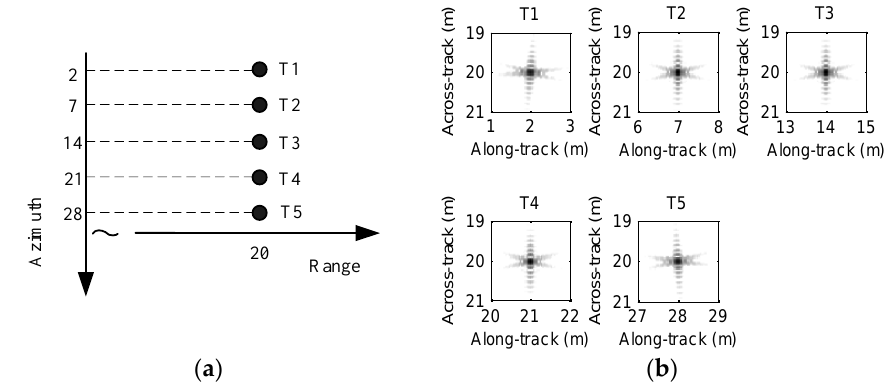
Figure 3. Simulated scenario and imaging result: ( a ) scenario with five-point targets; ( b ) imaging result without motion error.